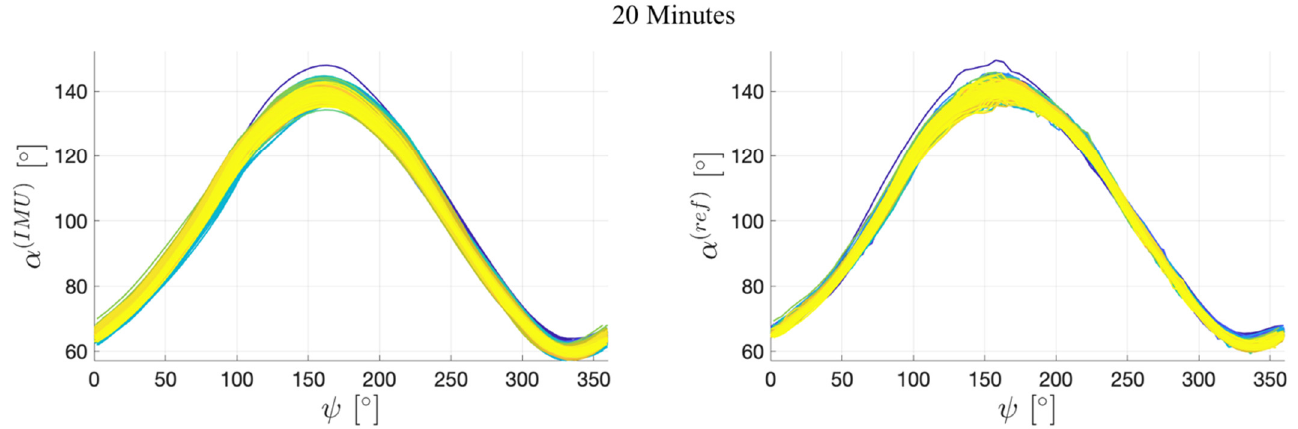
Figure 8. Knee joint angles obtained using the proposed IMU-based method and reference optical